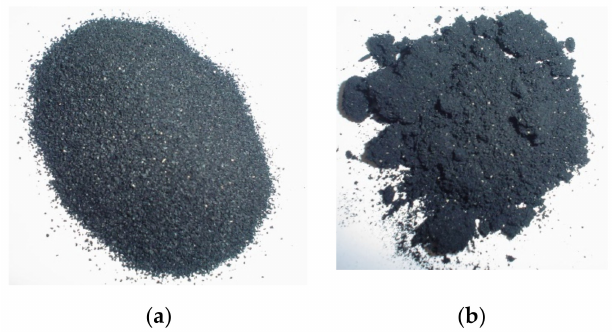
Figure 1. Crumb rubbers visual appearance. ( a ) Cryogenic crumb rubber. ( b ) Ambient crumb rubber.